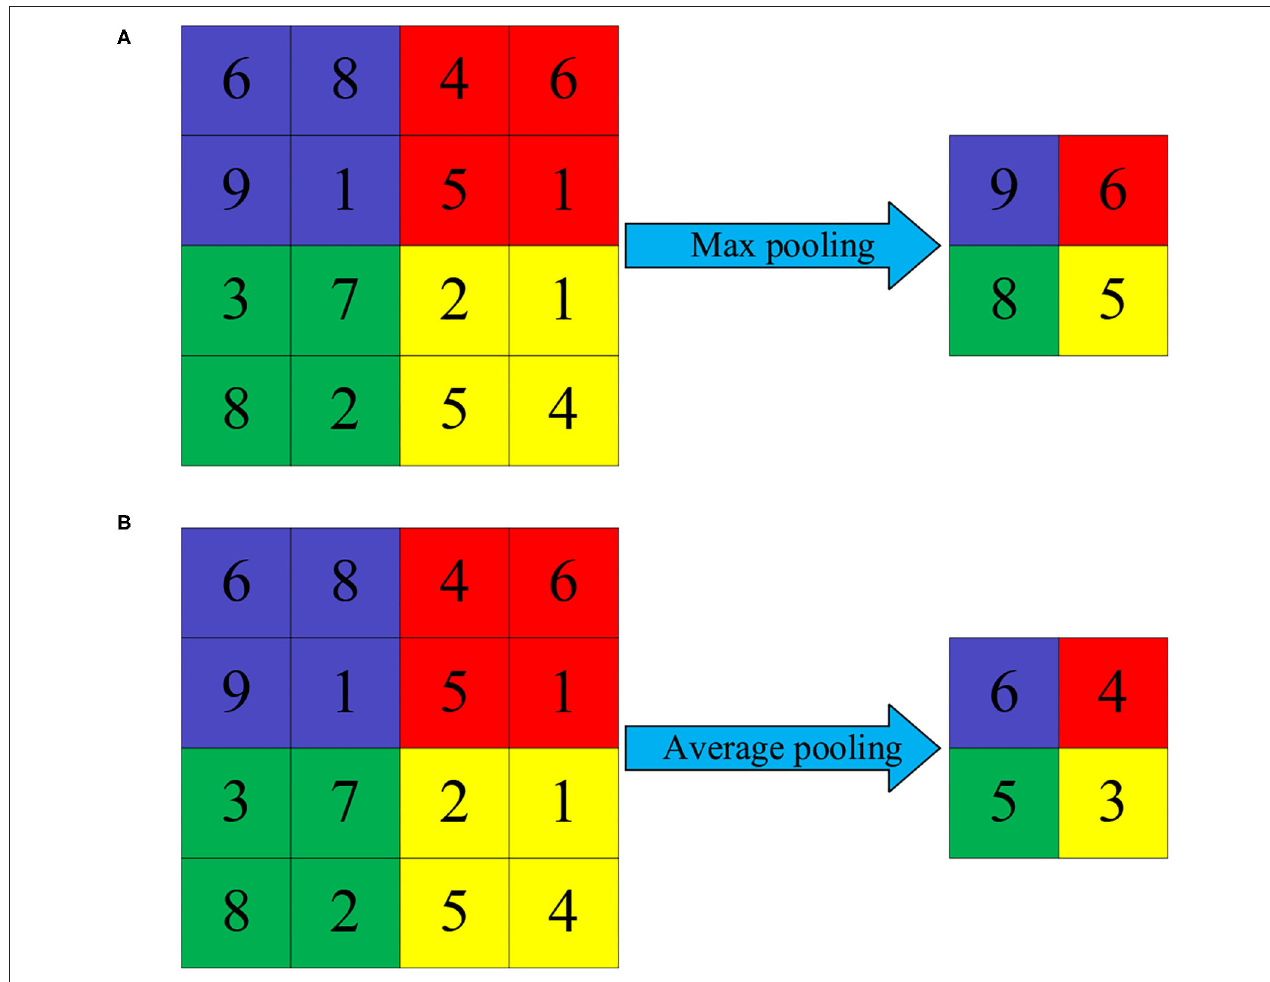
FIGURE 1 | Schematic diagram of pooling operation. (A) Maximum pooling and (B) average